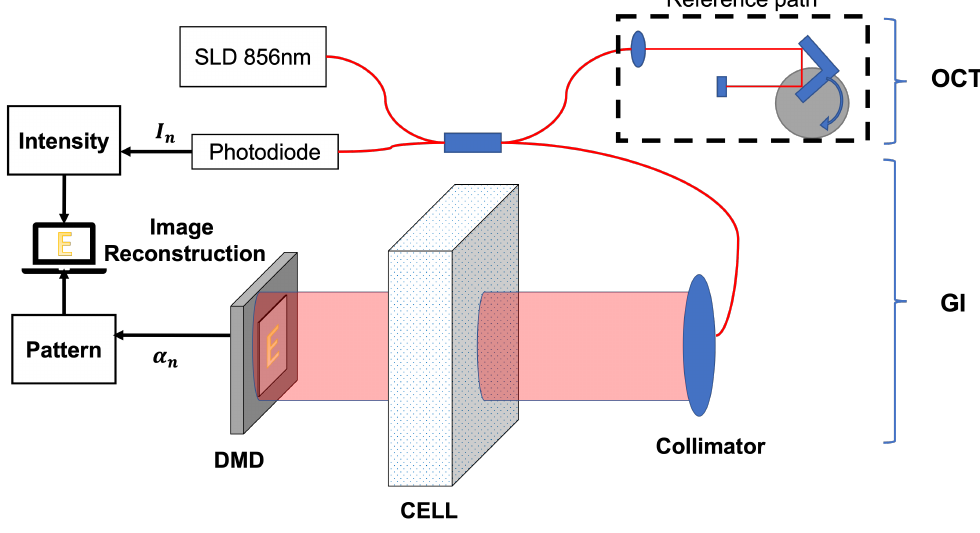
Figure 1. Experiment setup of GI-OCT for scattering media measurement.